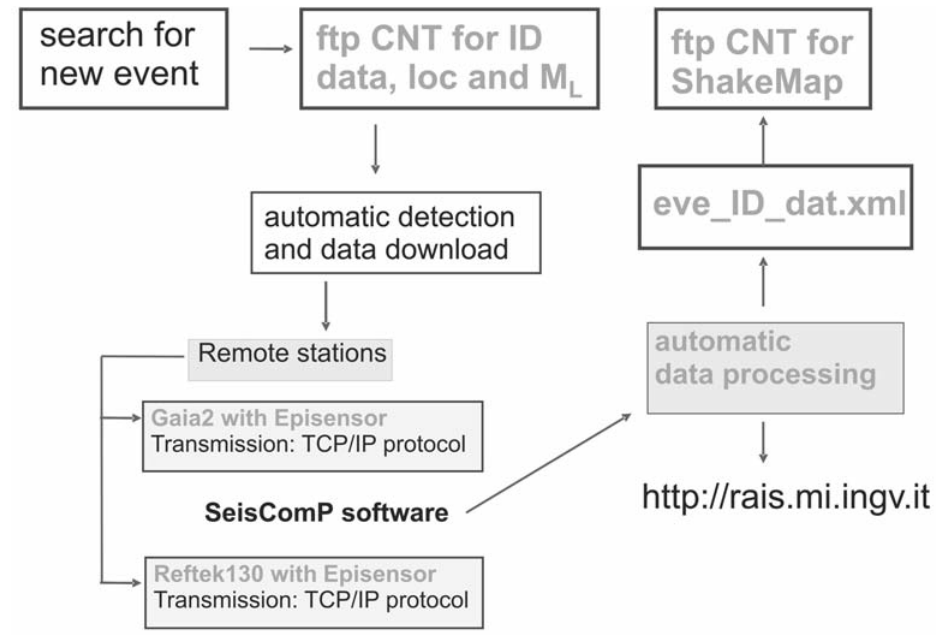
Figure 6. Flow chart representing the acquisition system and data transmission for the RAIS